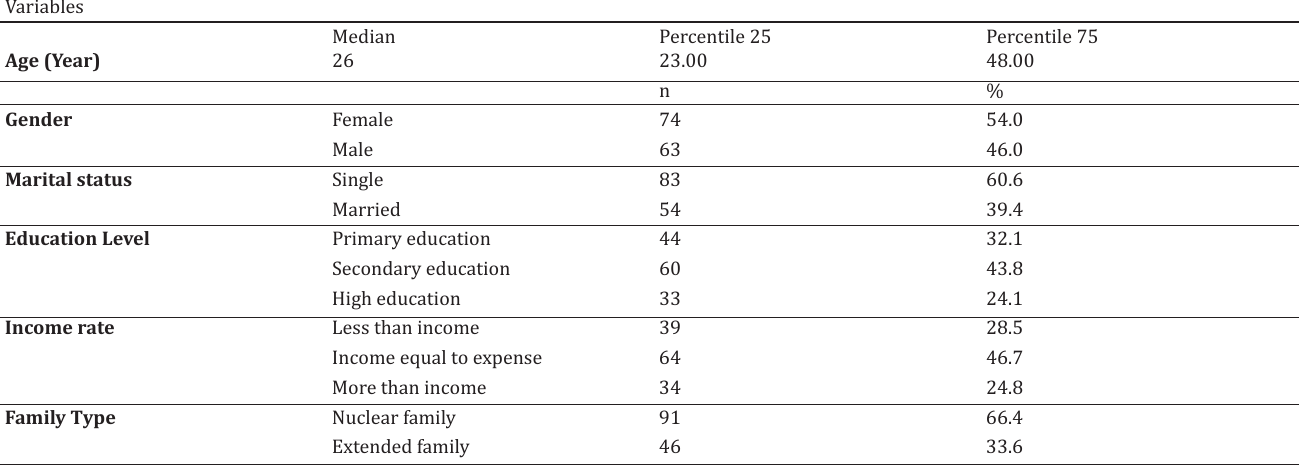
Descriptive Characteristics of Individuals (N =